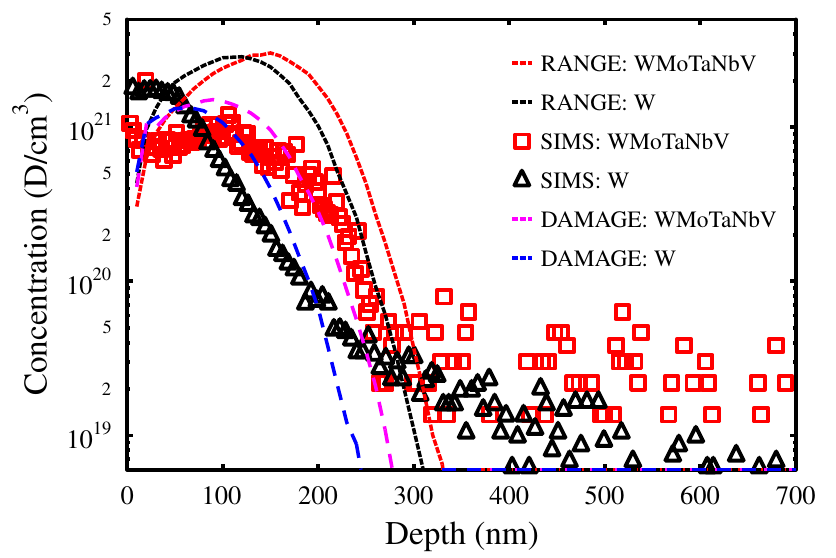
Figure 1. Concentration profiles of D in WMoTaNbV and W. The profiles were measured by SIMS and calibrated with the total D amounts from ERDA. The SRIM profiles show approximately how the profiles would look if there were no D diffusion. Displacement threshold energies used were W = 90 eV, Mo = 65 eV, Nb = 78 eV, Ta = 90 eV and V = 57 eV [11]. The units of SRIM-calculated damage profiles are